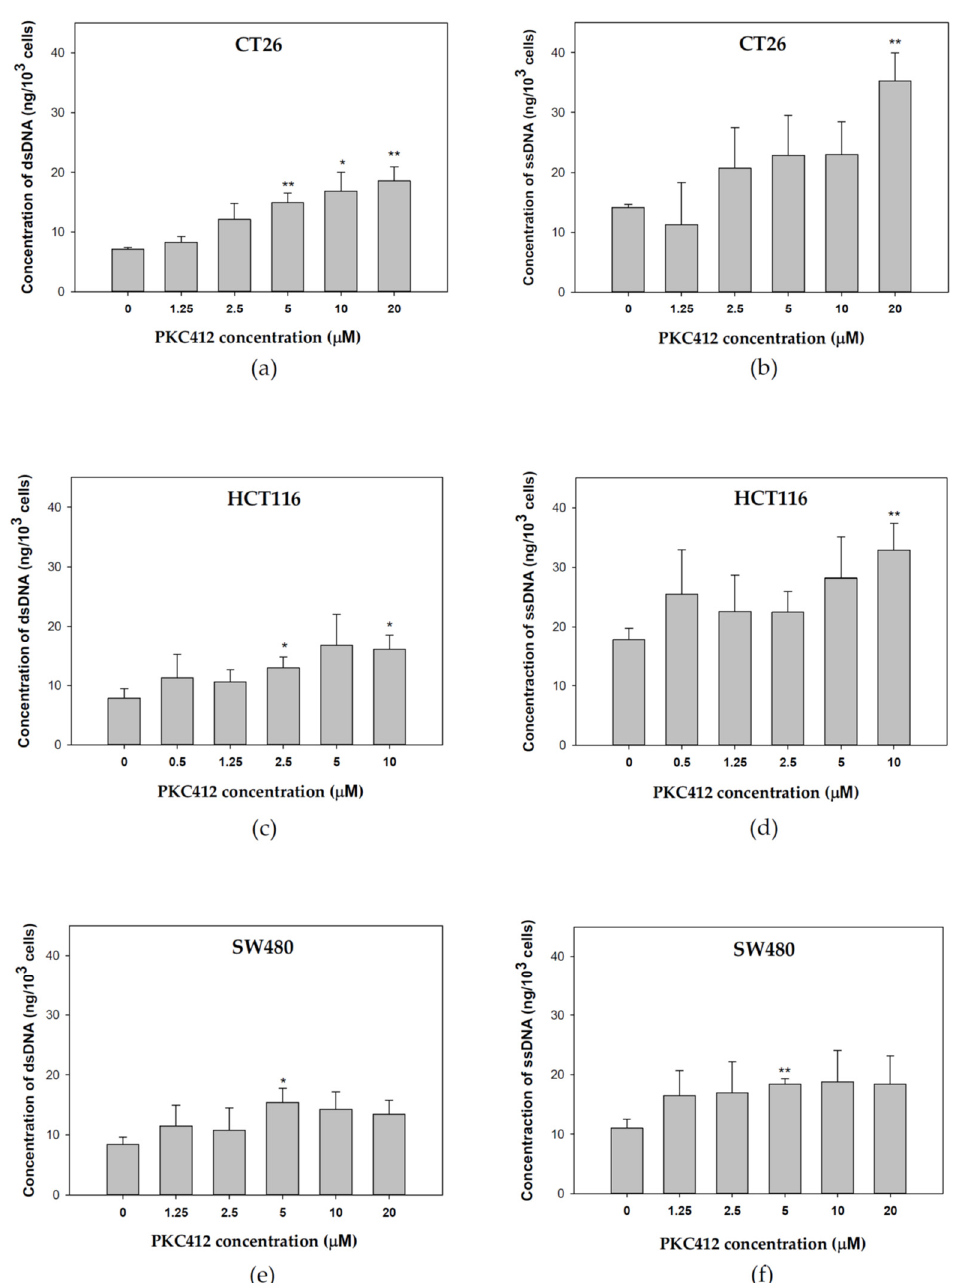
Figure 4. Cytosolic DNA expression profiles after midostaurin (PKC412) was administered in colorectal adenocarcinoma cells. CT26 ( a , b ), HCT116 ( c , d ), and SW480 ( e , f ) cells were grown in monolayer and treated with midostaurin for 24 h. After treatment, cells were detached, harvested, and the cell pellet was added with lysis solution to disrupt the cells. The samples were then centrifuged at 1200 rpm for 5 min and the supernatant containing cytosolic DNA was collected. The double-strand DNA (dsDNA) ( a , c , e ) and single-strand DNA (ssDNA) ( b , d , f ) were measured at 260 nm wavelength. Data from three separate experiments were expressed as mean ± SEM. Significant differences between control cells and cells treated with PKC412 are indicated by * p < 0.05 and ** p < 0.01.